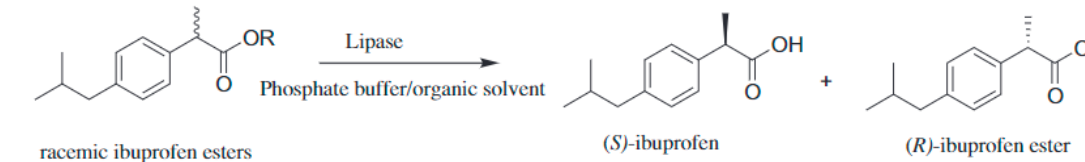
Figure 7. Lipase-catalysed enantioselective hydrolysis of racemic ibuprofen esters [281].